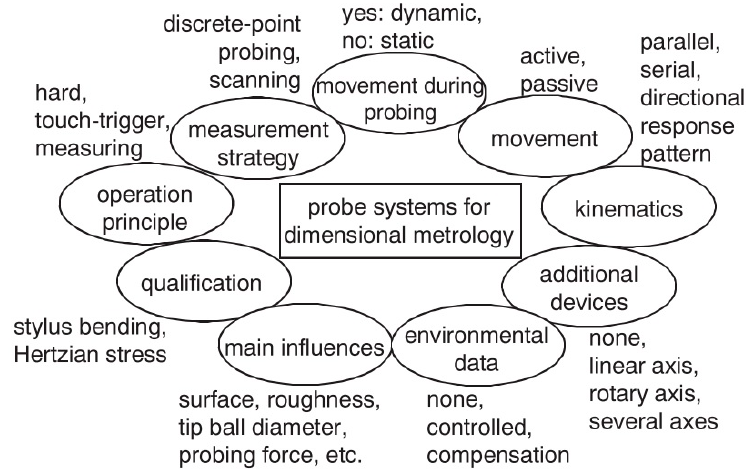
Figure 15. Aspects of probing systems [119].